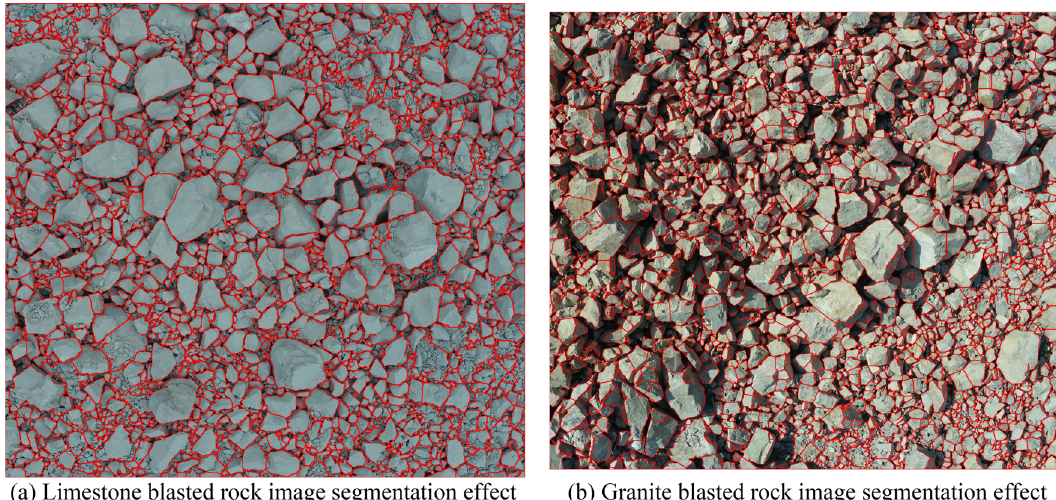
Figure 21. The segmentation effect using the segmentation method of the literature 45 .